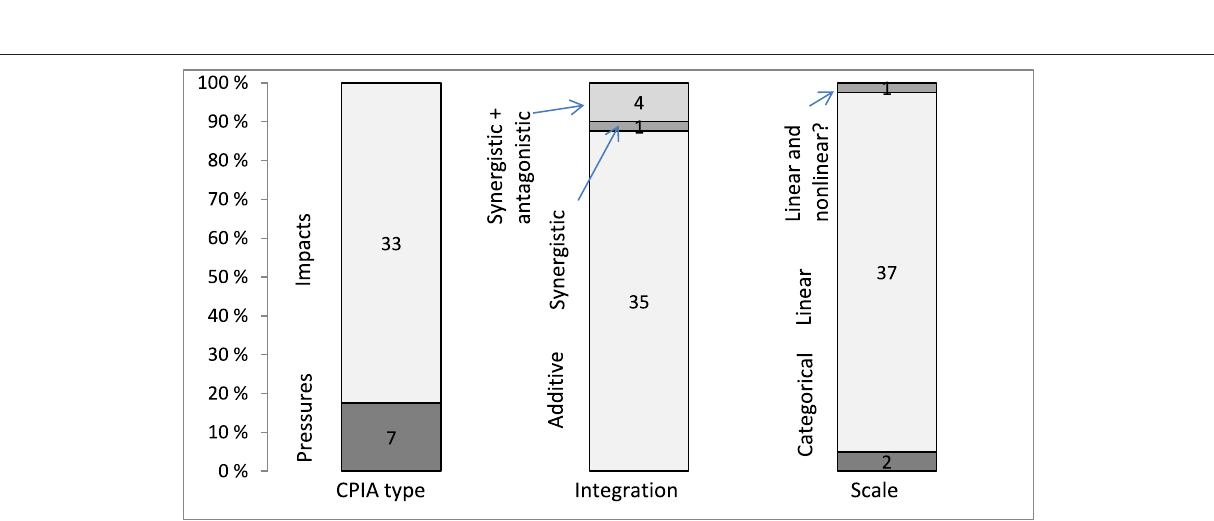
Frontiers in Marine Science |